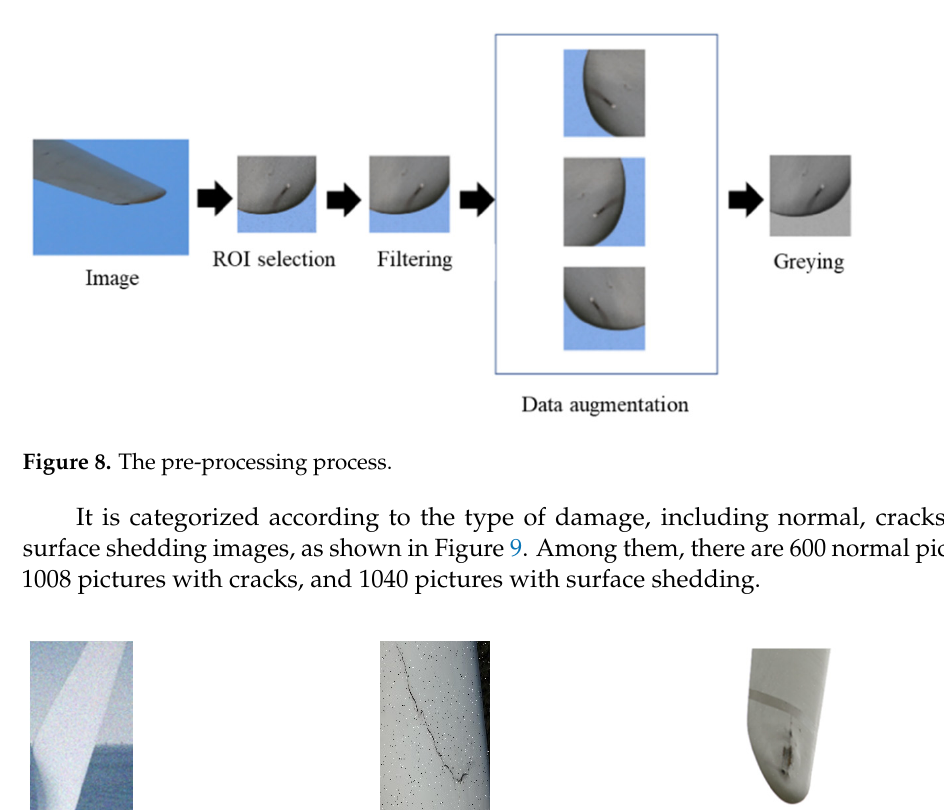
Figure 9. Three types of wind turbine blade pictures. ( a ) Normal; ( b ) cracks; ( c ) surface shedding.